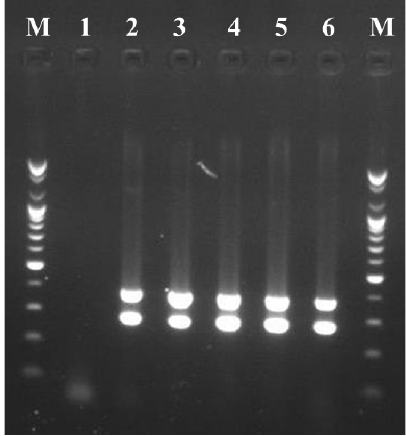
Figure 1. Duplex PCR assay was conducted to identify Vp AHPND . Lane M: 100-bp DNA ladder; lane 1: negative control; lane 2: Vp AHPND positive control (from a shrimp farm in Vietnam); lane 3: hepatopancreas of shrimp frozen at − 80 °C for two weeks; lanes 4 and 5: Vp AHPND isolates from frozen hepatopancreas; lane 6: dead shrimp after feeding on frozen hepatopancreas. Representative samples of each analysis are shown.